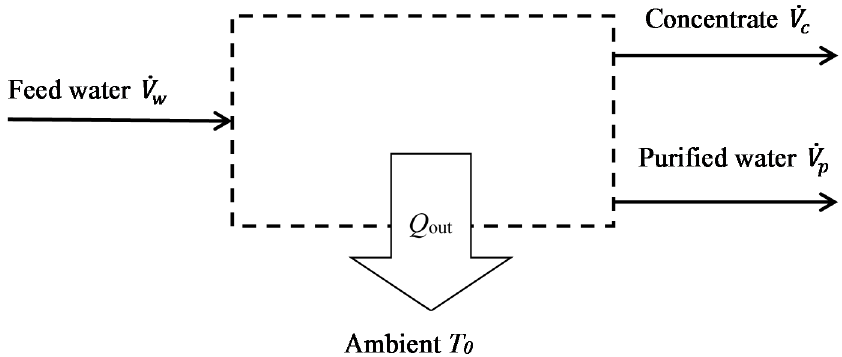
Figure 1. Self-powered geothermal desalination plant represented as a control volume that includes geothermal energy conversion and desalination